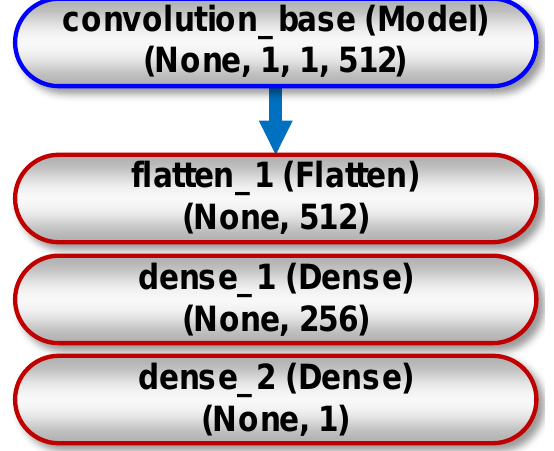
Figure 8. General scheme for implementing deep neural network consisting of a convolutional base (blue line) and own classifier (red line) for binary classification. The meaning of the Keras classes visible on the individual layers is as follows: Flatten—converts a 3-dimensional tensor to a 1-dimensional vector; Dense—densely connected layer. The feature map has a shape (samples, height, width, channels). The None parameter corresponds to any number of samples.